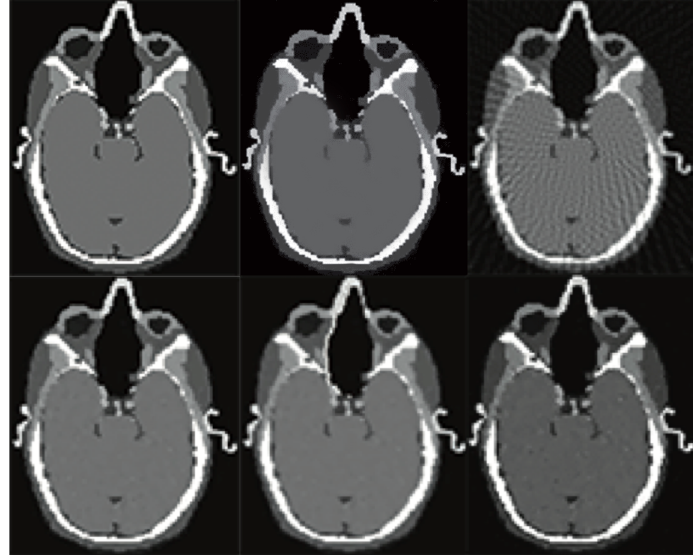
Figure 4. The Zubal phantom images based experiment results for the cases exposed in Table 2 rows numbers: 1, 2, 3. The bottom row refers to: Table 2 rows numbers: 4, 5,